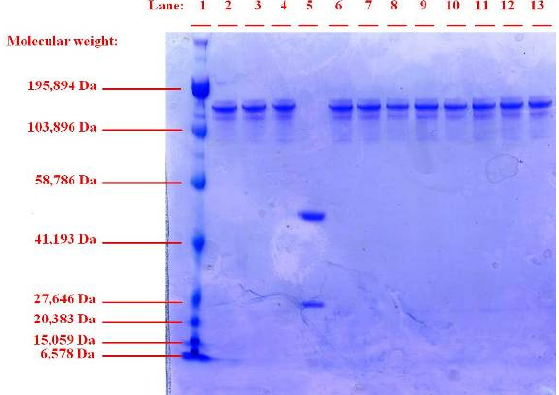
Figure 2. SDS-PAGE showing: molecular weight ladder (Lane 1), native trastuzumab (Lanes 2–4), chemically reduced trastuzumab (Lane 5), spray-dried trastuzumab (Lane 6), trastuzumab freeze-thawed x 6 cycles (Lanes 7–8) , trastuzumab sonicated at; 1 Watt × 1